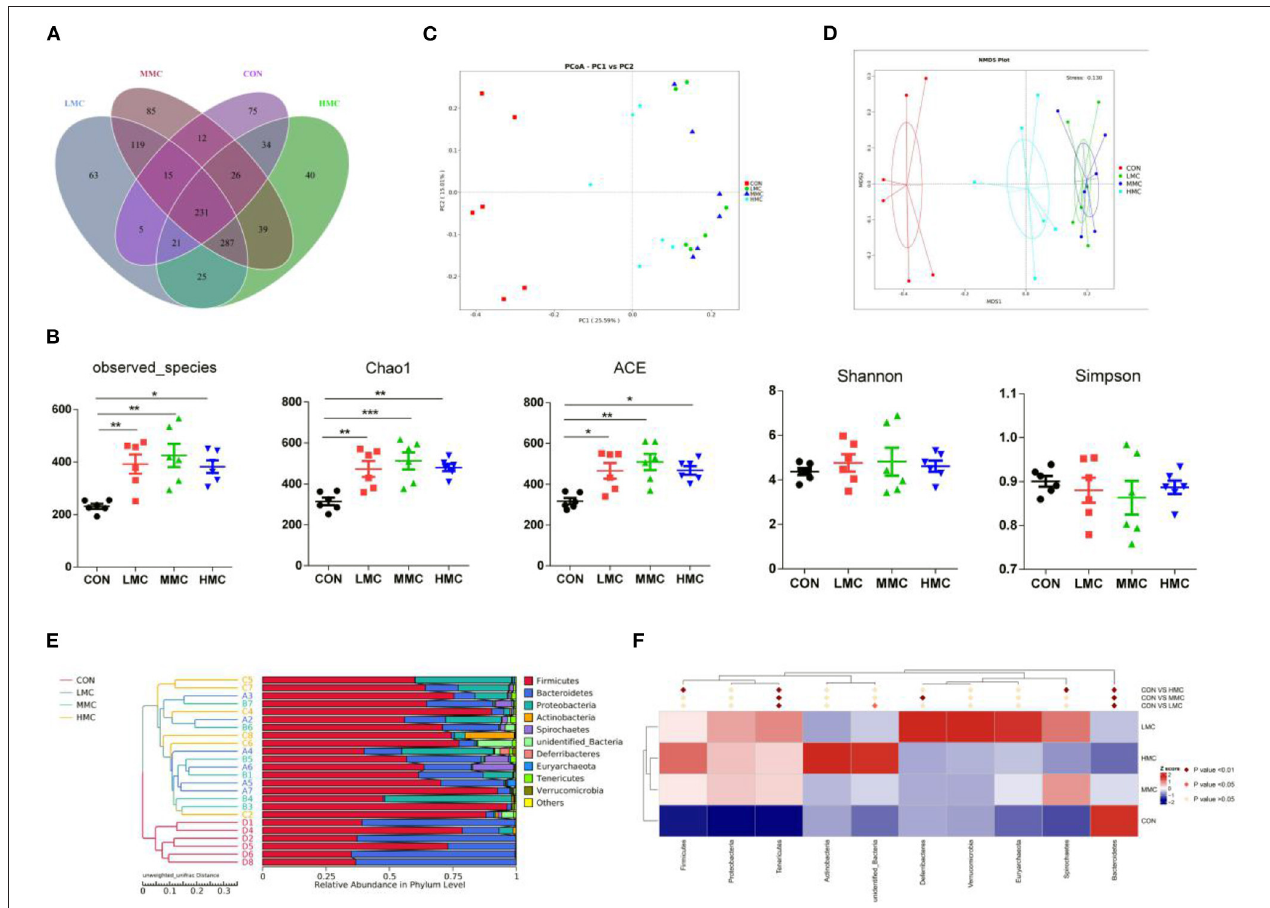
FIGURE 4 | Effect of dietary Moutan cortex radicis on the colonic microbiota diversity and composition in the pigs. (A) A Venn diagram illustrating the overlaps of OTUs in the gut microbiota; (B) The microbial alpha diversity indices (Observed-species, Chao1, Shannon, Simpson, ACE) were calculated using the mothur program; (C) Principal coordinate analysis (PCoA); (D) non-metric multidimensional scaling (NMDS) analysis; (E) unweighted UniFrac cluster tree based on Unweighted Pair-group Method with Arithmetic Mean (UPGMA) analysis; (F) The significant different species among groups based on MetaStat analysis. CON, control group, basal diet without antibiotics; LMC, the control diet + 2,000 mg/kg Moutan cortex radicis ; MMC, the control diet + 4,000 mg/kg Moutan cortex radicis ; HMC, the control diet + 8,000 mg/kg Moutan cortex radicis . Data are expressed as means ± SEM ( n = 6). * P < 0.05, ** P < 0.01, and *** P <